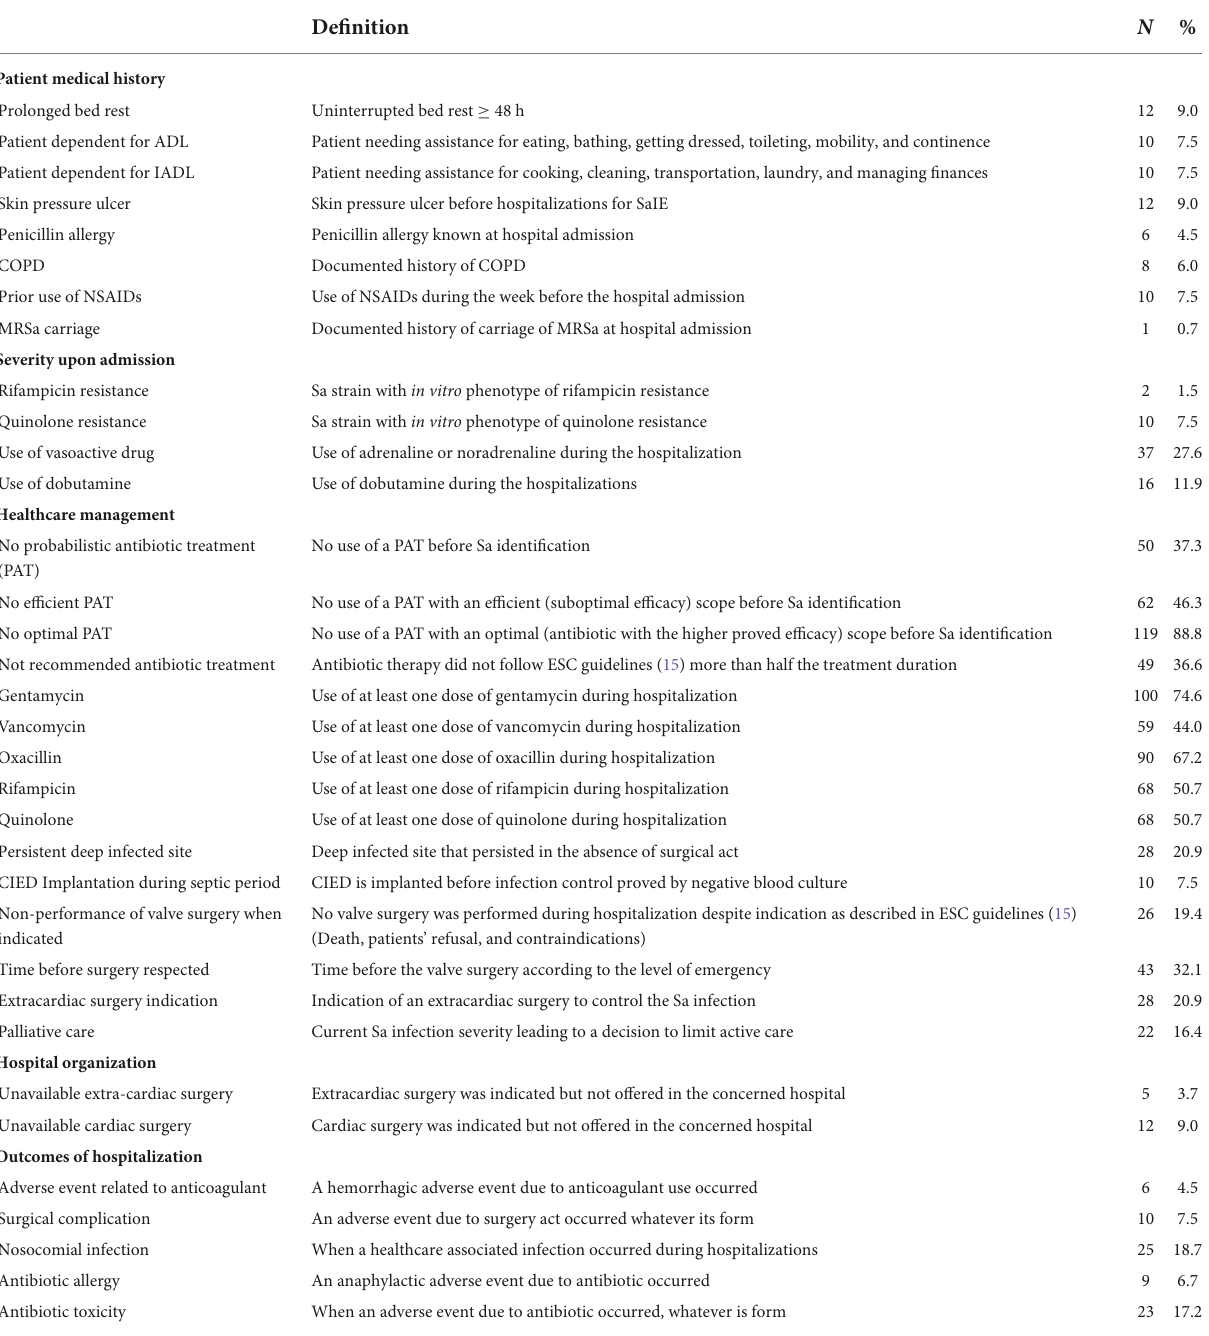
TABLE 3 Description of factors that could be associated with death in the 134 Staphylococcus aureus infective endocarditis